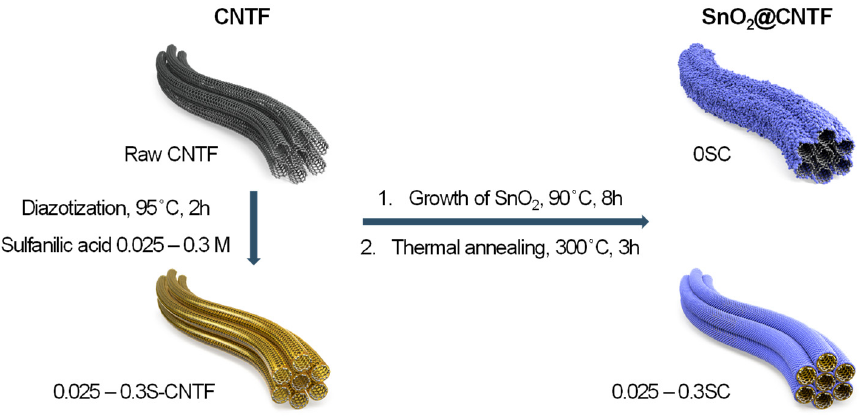
Figure 1. Schematic representation of preparation processes and name of the samples in this work. S2p XPS spectra quantitatively showed the degree of functionalization of surface- modified CNTF (Figure 2a). The XPS spectra indicated that the raw CNTF also had sulfur atoms, because thiophene was used to grow CNTF in the direct-spinning process. In particular, we used a larger amount of sulfur precursor in this study to prepare the CNTF with high linear density [8,24], which resulted in the noticeable S2p peak of raw CNTF. The intensity of the S2p spectra increased as the concentration of sulfanilic acid used in the functionalization process increased except for the condition of 0.3 M sulfanilic acid. When the concentration of sulfanilic acid was too high, the sulfanilic acid remained undissolved until the reaction finished due to the low solubility of sulfanilic acid. The undissolved sulfanilic acid was deposited on the CNTF and prevented functionalization. Quantitative analysis of the atomic ratio of CNTF indicated that the CNTF versions functionalized by 0.1 M and 0.2 M sulfanilic acid had the highest degree of functionalization (Figure 2b).